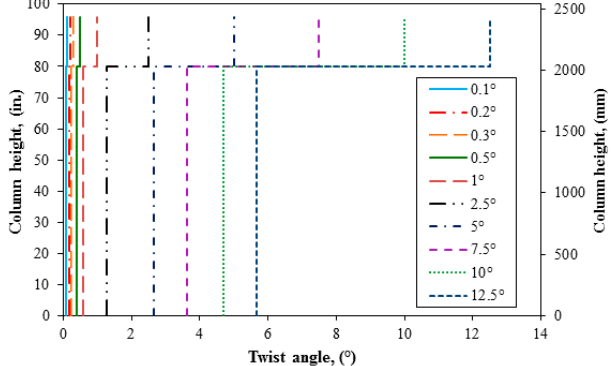
Figure 9. Variation of the twist angle along the column height.